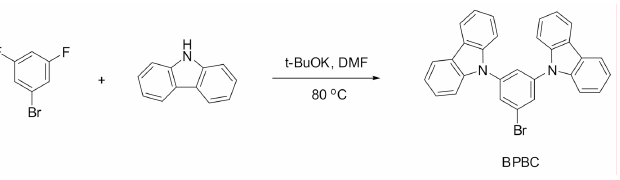
Figure 1. The synthetic procedure of 9,9 (cid:48) -(5-bromo-1,3-phenylene)biscarbazole (BPBC).